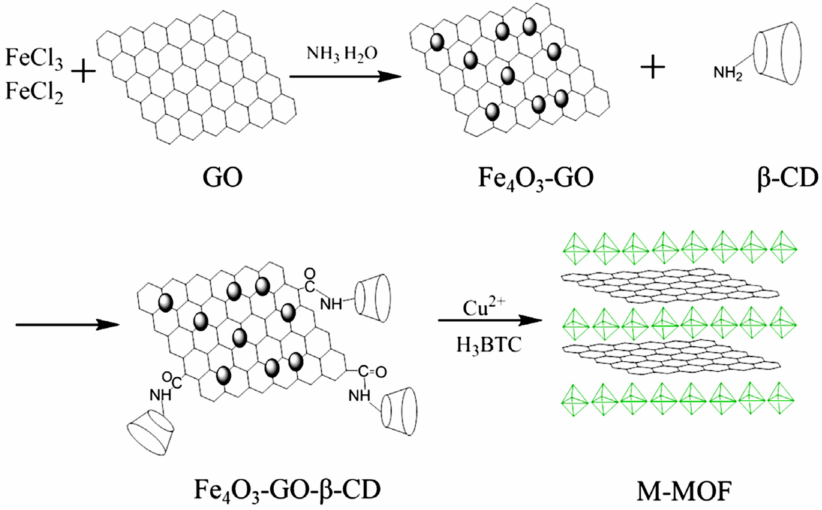
Figure 20. Synthesis of the HKUST-1-Fe 4 O 3 -GO- β -CD (M-MOF) nanocomposite. Reprinted with permission from